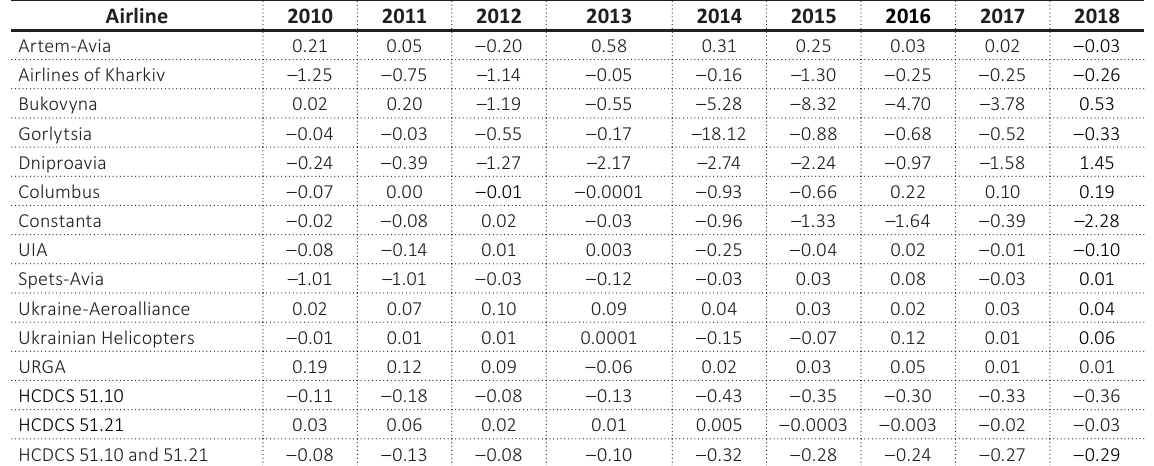
Table 1. Profitability (loss) of sales of Ukrainian airlines in 2010–2018